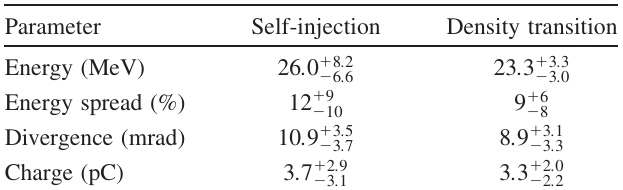
TABLE I. Comparison self-injection and shock-front injec- tion. Parameter